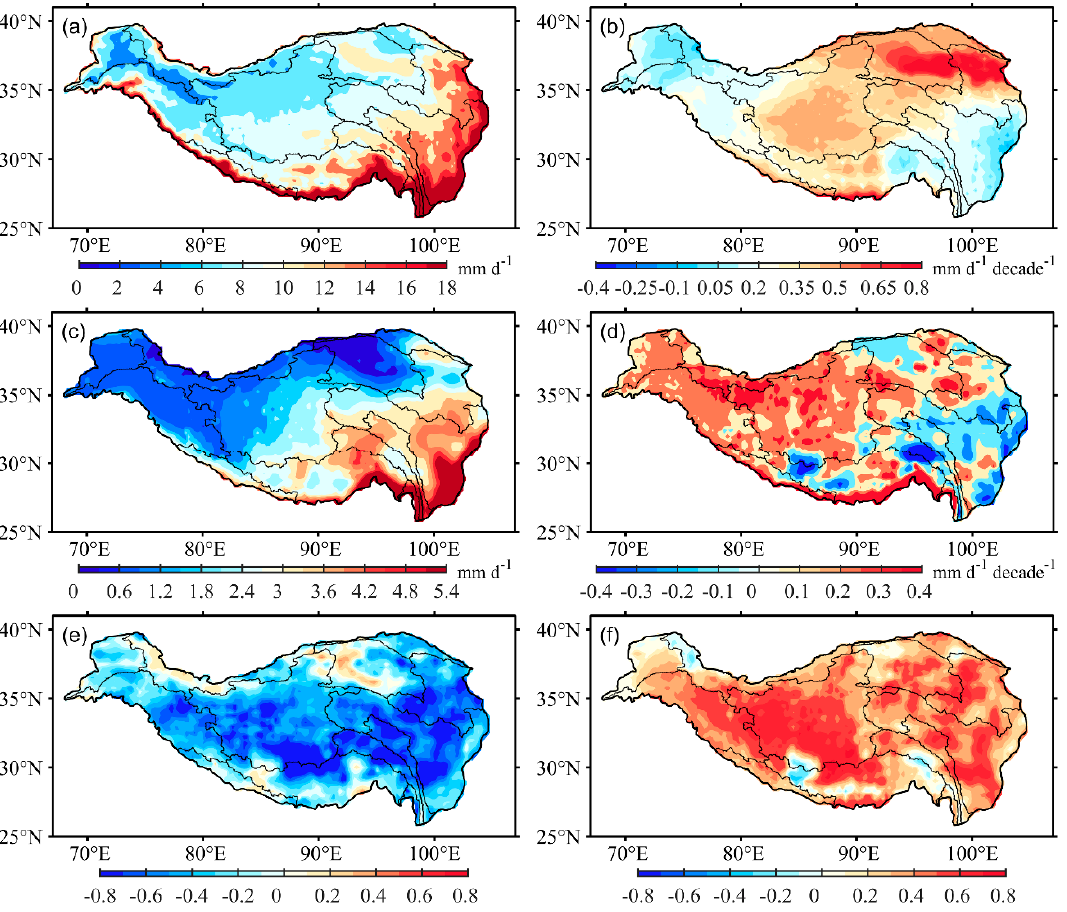
Figure 6. Distribution of summer precipitable water (PW) and precipitation over the TP ( a , c ) unit: mm d − 1 ) and their changing trends ( b , d ) unit: mm d − 1 decade − 1 ), and spatial correlation distribution of precipitation with water vapor flux divergence and PW ( e , f ).